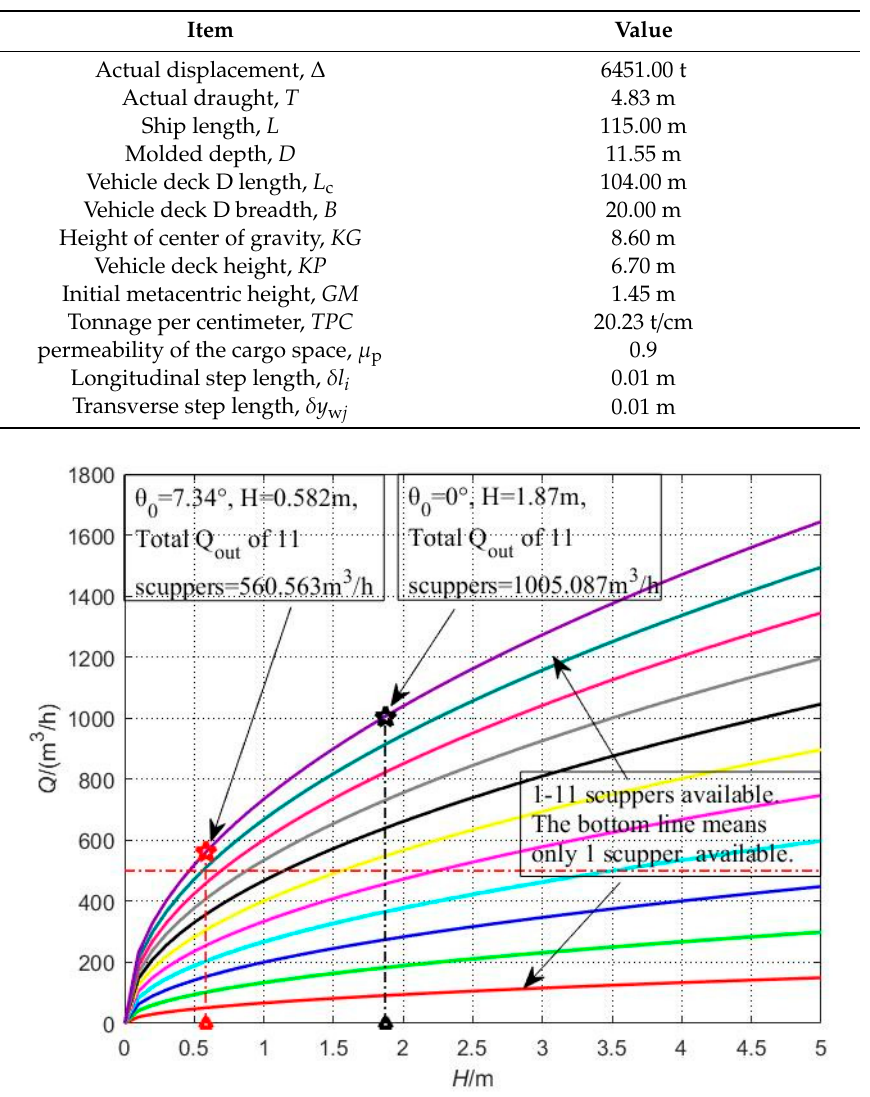
Table 3. The particulars of the loading conditions of the M / V Dashun at the time of the accident.